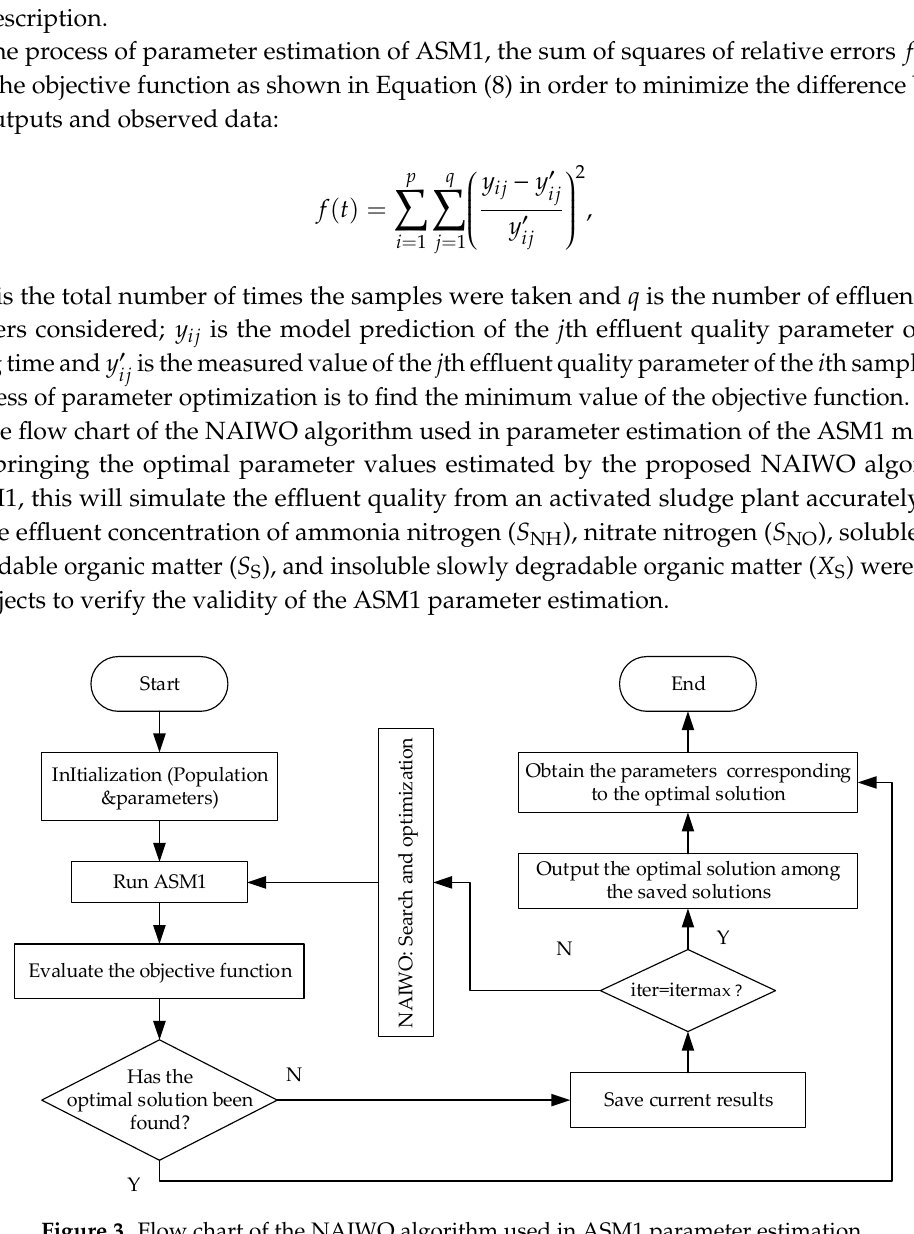
Figure 3. Flow chart of the NAIWO algorithm used in ASM1 parameter estimation. Table 1. Nineteen parameters of ASM1.